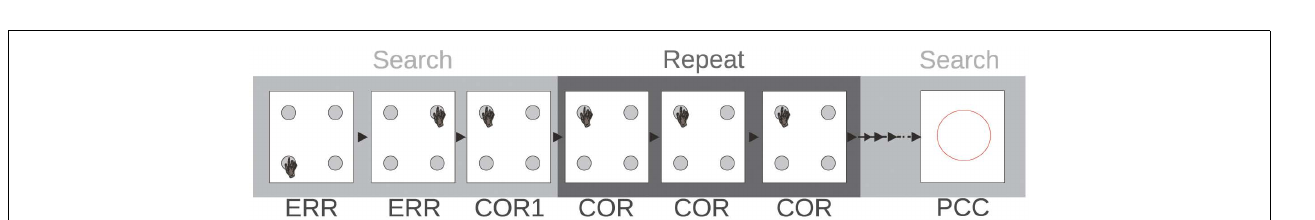
problem, a single target is associated with reward with a probabil- ity of one (deterministic). At each trial, the four targets appear on the screen and remain visible during a 5-s delay. The robotic arm should touch one of the targets before the end of the delay. Once a touch is detected on the screen, the targets disappear and the choiceisevaluated.If thecorrecttargetischosen,atriangleappears on the screen, symbolizing the juice reward monkeys obtain. For incorrect choices, the screen remains black for another 5-s delay